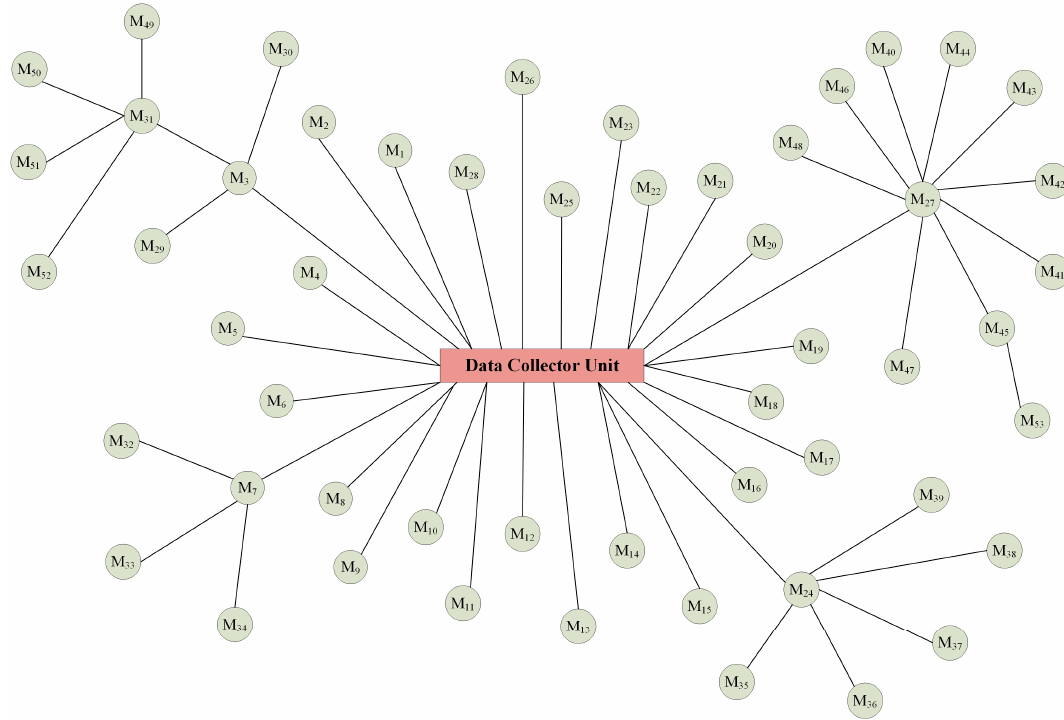
Figure 15. Communication Network Configuration of Actual Small-Scale PLC-based AMI. Table 4. Meter Number for the Actual Small-Scale PLC-based AMI.